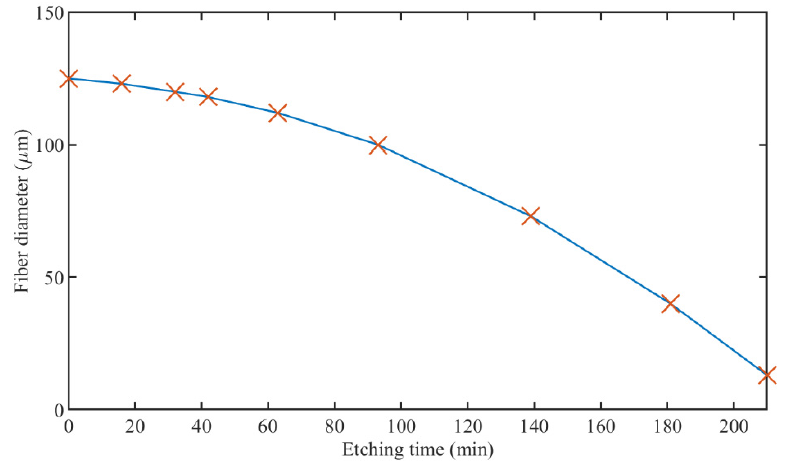
Figure 2. Evolution of TFBG diameter after etching in 48% HF solution. Markers show diameter values after each etching step; blue line—quadratic fitting of the curve.